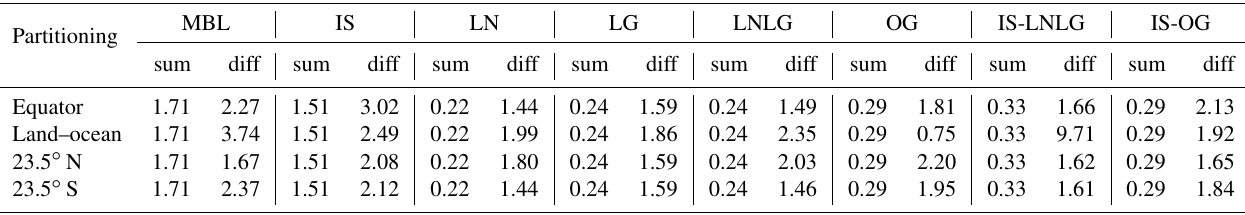
Table 3. The spread in the flux partitioning across five models from the assimilation of different pseudo-data streams. This is a tabulated summary of the information in Figs. 7 and 8. For each pseudo-data stream (e.g., MBL) and each partitioning (e.g., 23.5 ◦ N, which is the dividing line between the northern extra-tropics and the rest), the table contains the spread across five models of the sum and difference of the fluxes between the two partitions. All numbers are in PgCyr − 1 . Partitioning